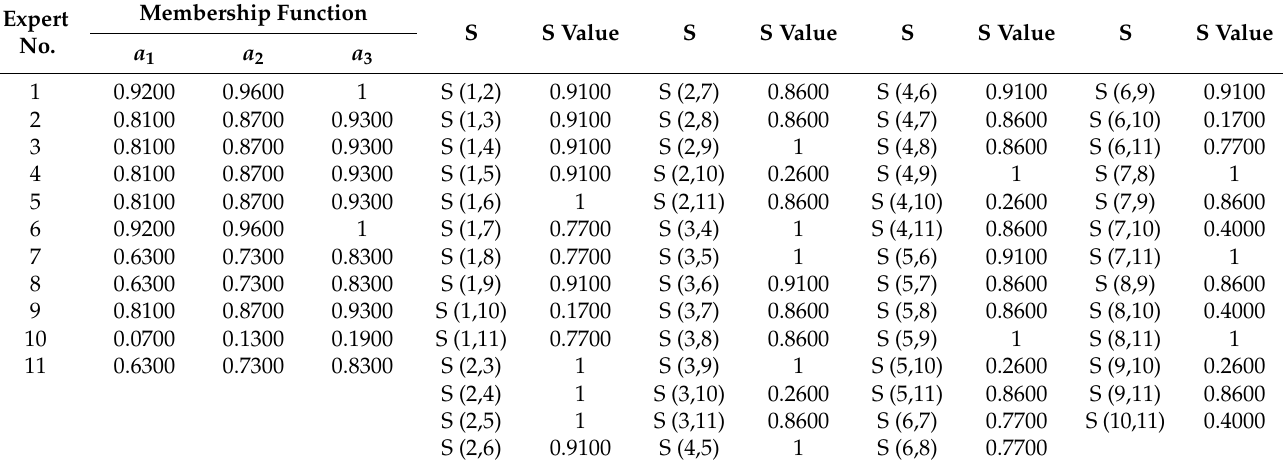
Table 6. The S values of BE 5.